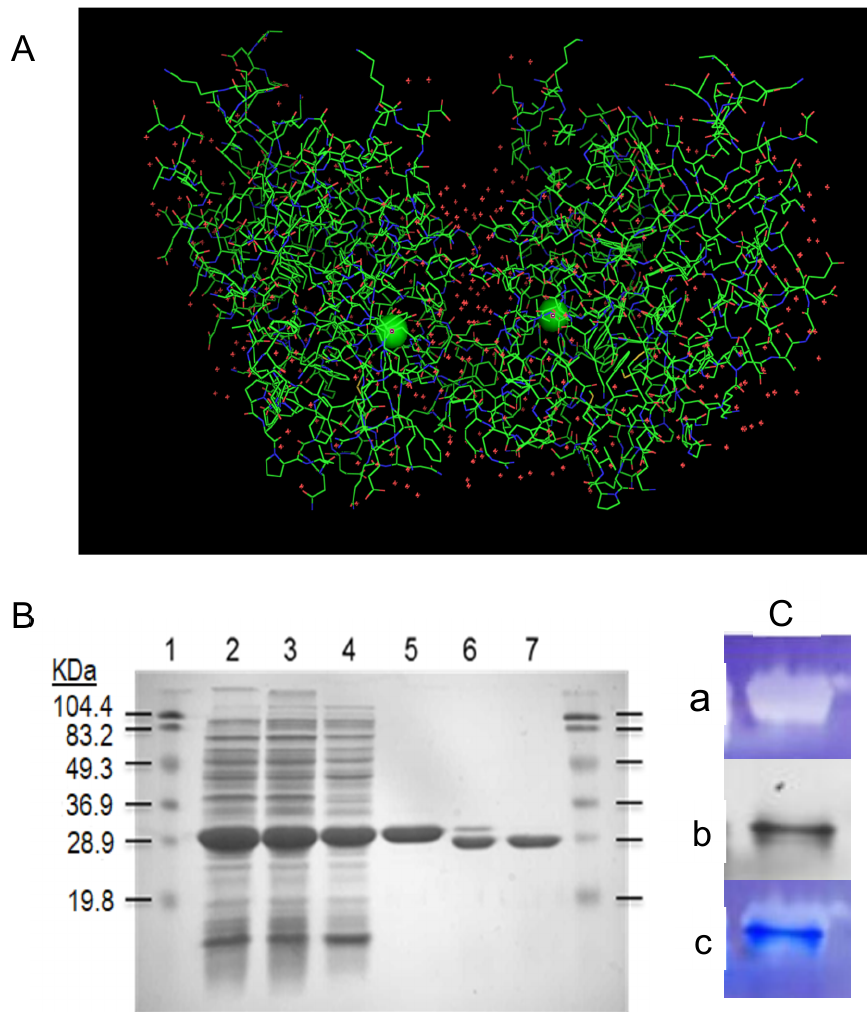
Figure 1. ( A ) Vu FeSOD dimer crystal structure: 3D model for the crystal structure dimer of the eukaryotic FeSOD from cowpea nodule cytosol, based on X-ray crystallography of FeSOD crystals (http://doi.org/10.2210/pdb1UNF/pdb accessed 21 October 2022). Iron atoms are presented as green circles. ( B ) SDS-PAGE gel of the r Vu FeSOD purification steps: samples were electrophoresed in a 12.5% SDS-PAGE gel and stained with Coomassie Blue. Line 1: Molecular mass markers (KDa); Line 2: Crude extract, Cell disruption; Line 3: Crude extract, pellet; Line 4: Crude extract, supernatant; Line 5: Pure r Vu FeSOD; Line 6: Pure r Vu FeSOD partially digested with thrombin; and Line 7: Pure r Vu FeSOD digested with thrombin. ( C ) r Vu FeSOD gel activity: (a) Gel stained for SOD activity assay (~2 μ g of protein), (b) replica gel stained with Coomassie blue brilliant, and (c) superposition of gel stained with Coomassie and gel stained for SOD activity.